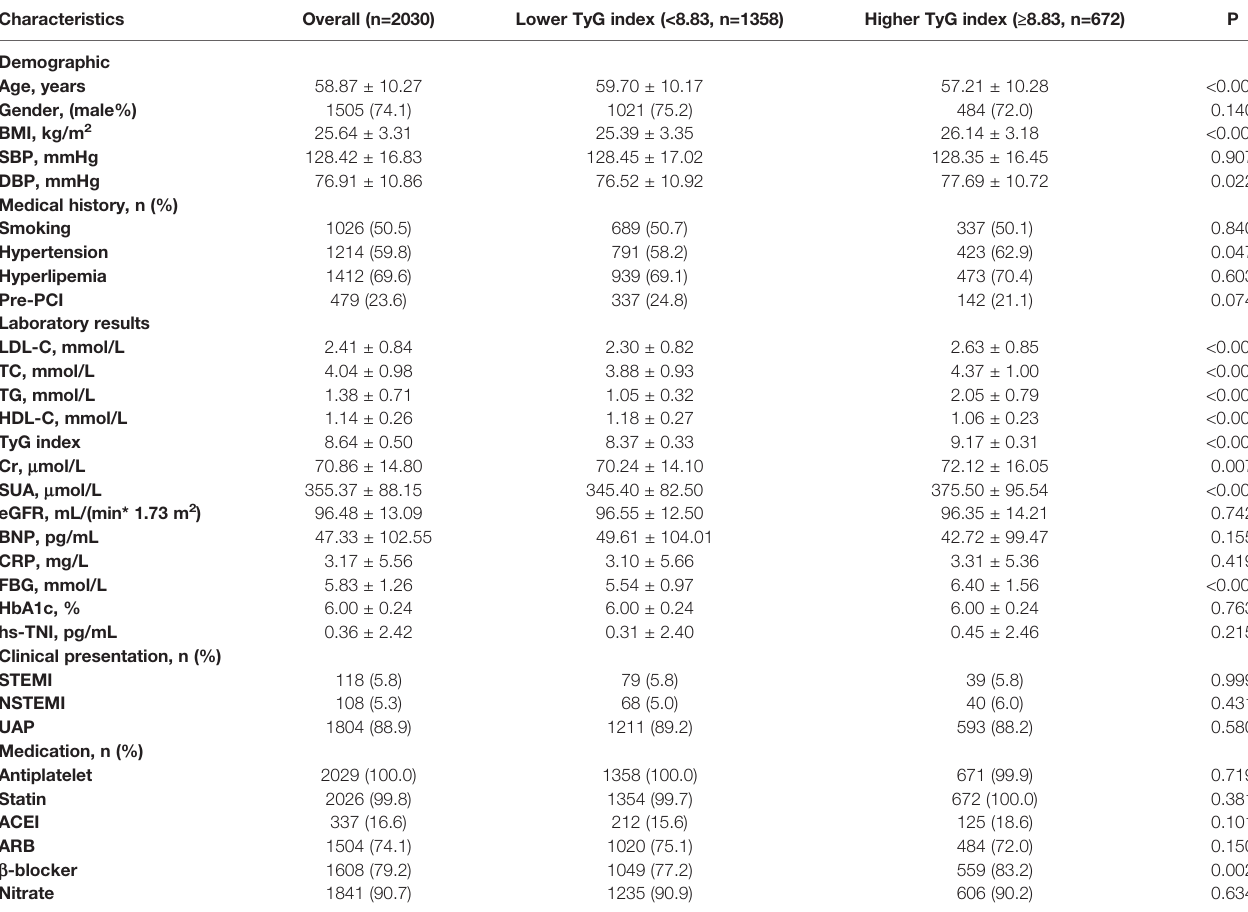
TABLE 2 | Baseline clinical characteristics of patients strati fi ed by the optimal cutoff point of TyG index.